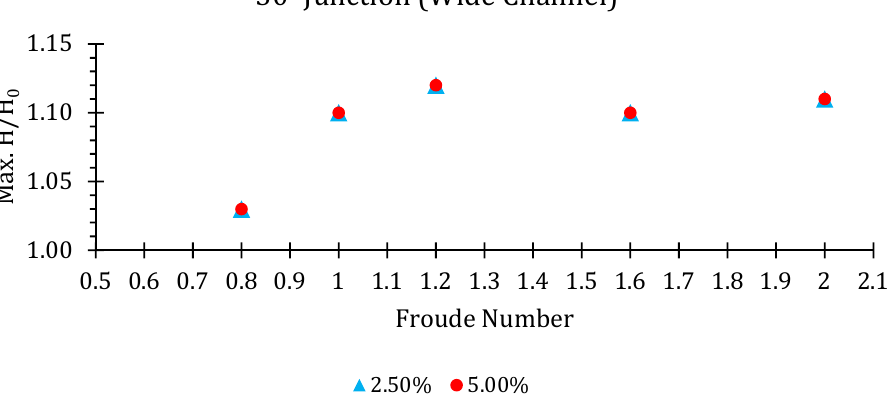
Figure 14. Maximum water height ratios in a 30° junction (wide channel).